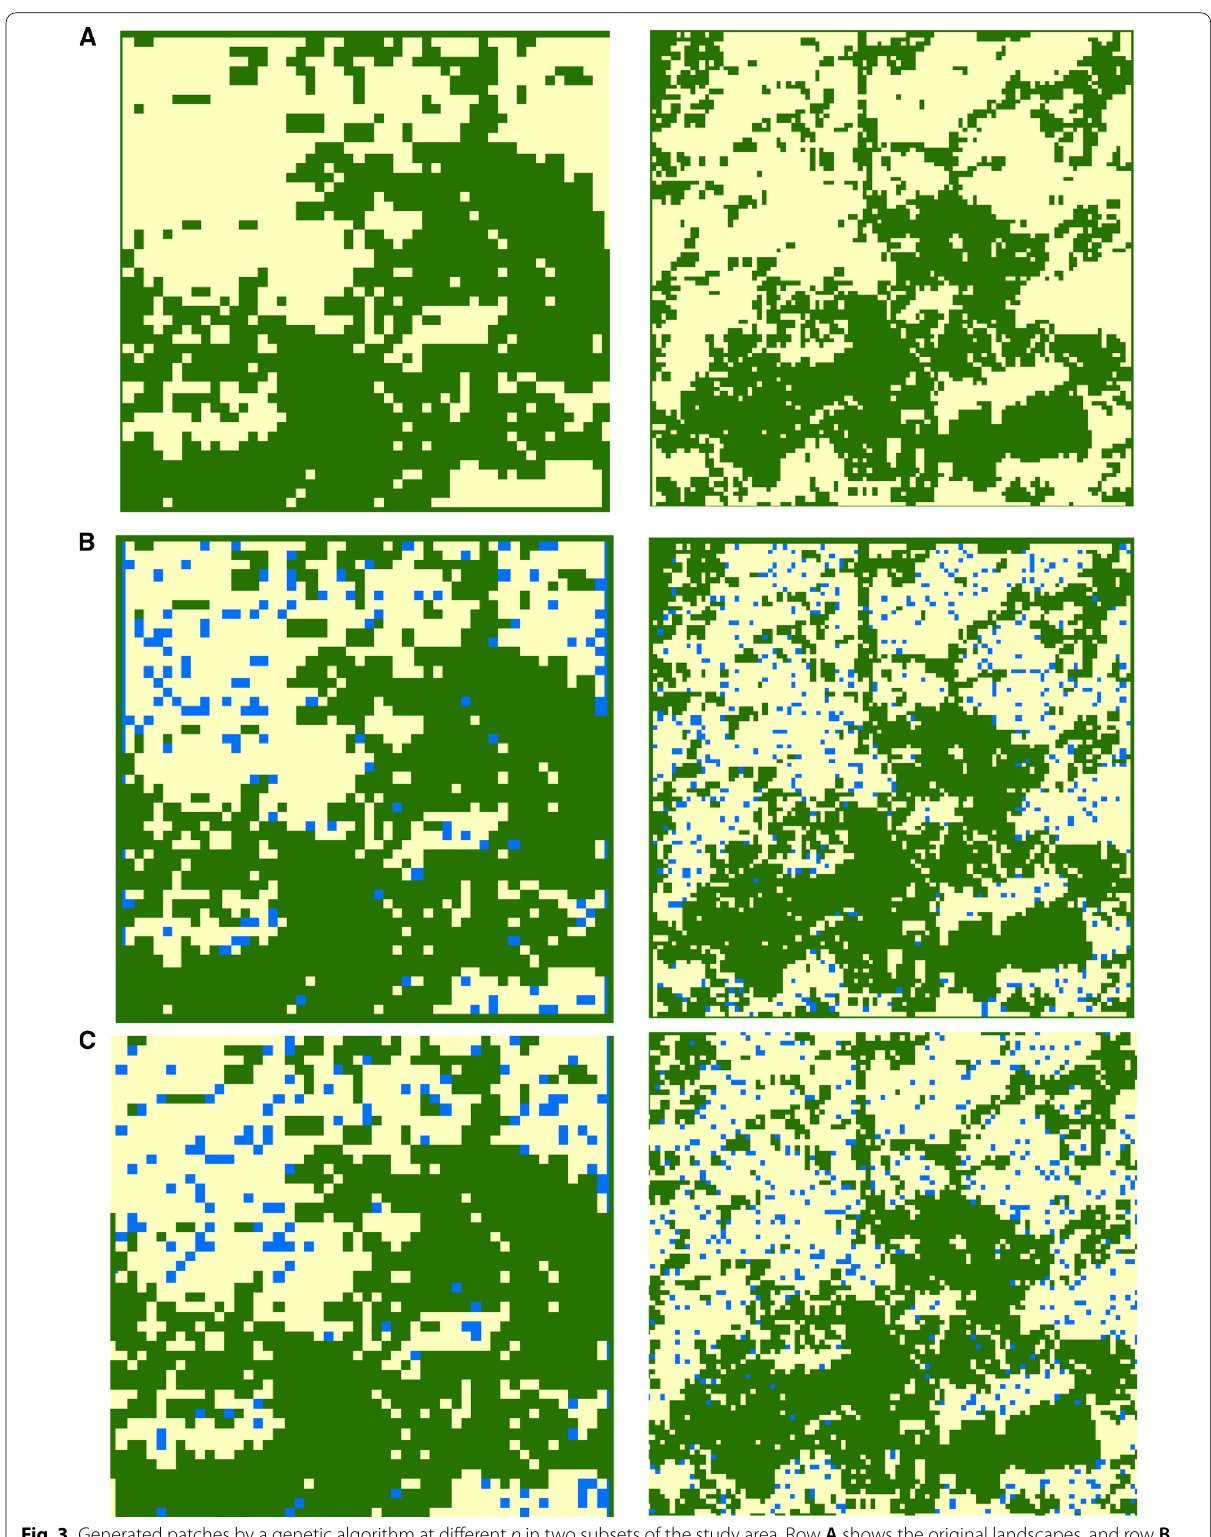
Fig. 3 Generated patches by a genetic algorithm at different p in two subsets of the study area. Row A shows the original landscapes, and row B shows the created patches’ location at p 0.16 that are located far away from original forest patches, and row C shows the created patches’ location = at p 0.001 that are located near the original forest patches. New patches are colored in =